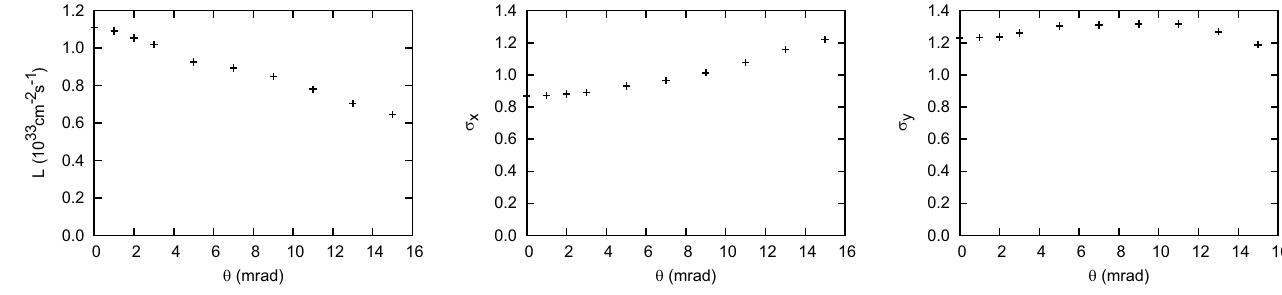
(cid:3) (cid:7) (cid:1) 0 : 51 ; 0 : 57 (cid:3) . The abscissa is half of the horizontal crossing ; 7 x y